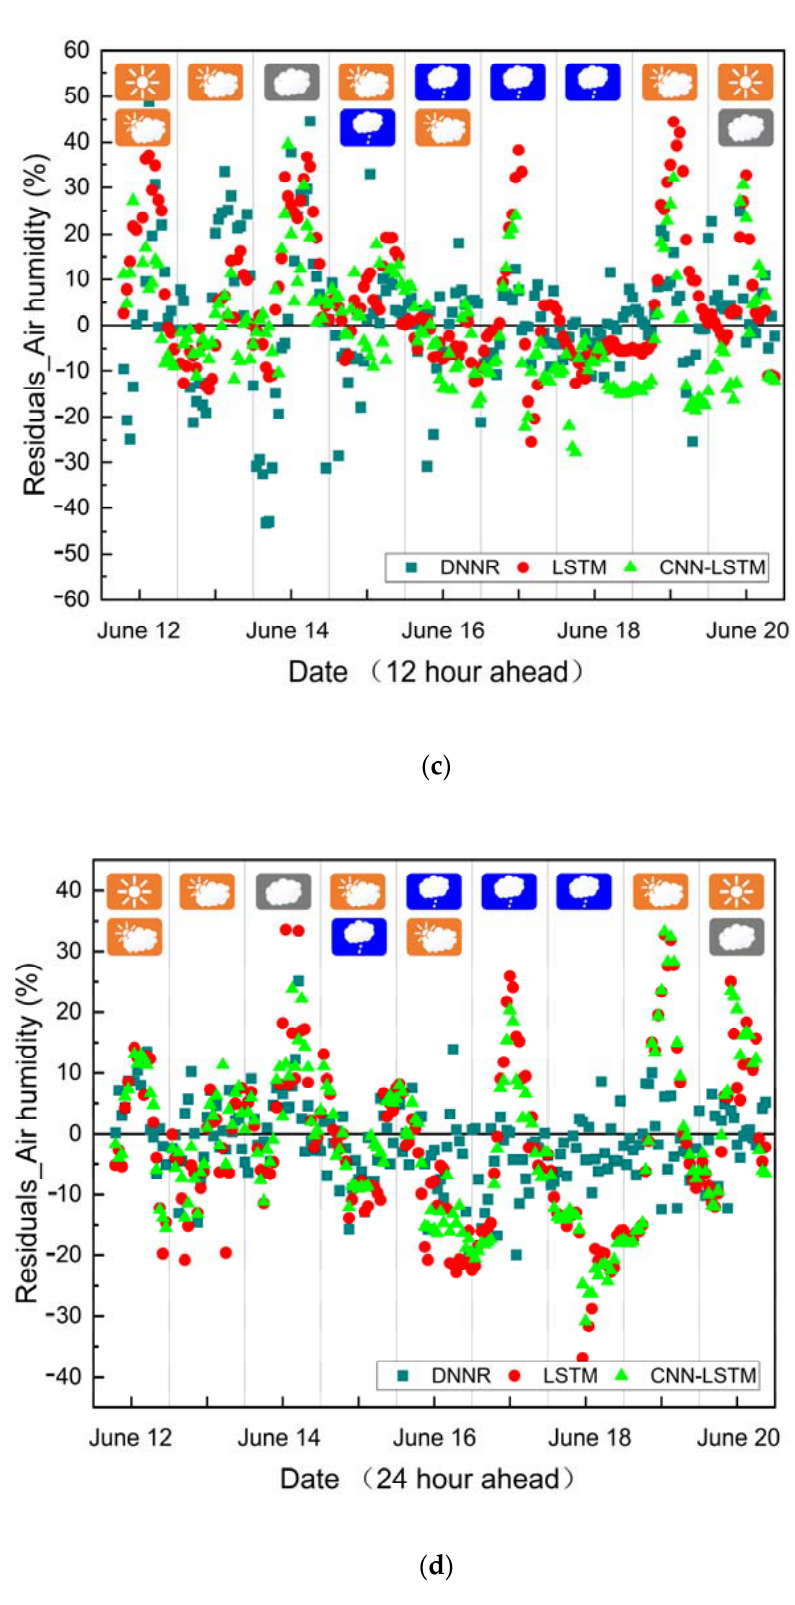
Figure 14. The ST of the three model errors for Greenhouse A humidity under different weather conditions; ( a ) 3 h advance, ( b ) 6 h advance, ( c ) 12 h advance, ( d ) 24 h advance. For the temperature of Greenhouse A, the statistics of the error distribution between the predicted value of the best model and the actual value at four forecast time points are shown in Figure 15. From the figure, the errors of the predictions of the DNNR model at four forecast time points are within [ − 5, 8], [ − 6, 6], [ − 8, 12] and [ − 7, 7] °C, respectively. The errors of LSTM model predictions at four forecast time points are within [ − 6, 9], [ − 6, 10], [ − 18, 17] and [ − 13, 11] °C, respectively. The errors in the predictions of the CNN ‐ LSTM